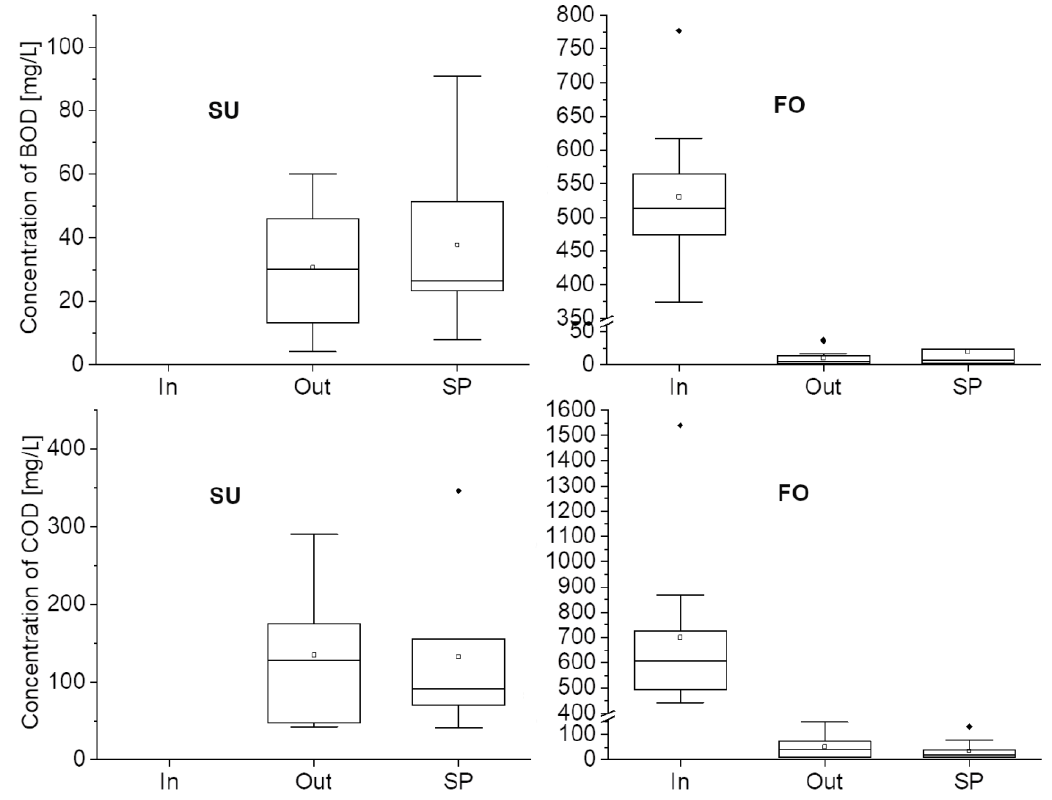
Figure 3. BOD 5 and COD concentration comparison during SU = start-up phase and FO = full-scale operation, In = inlet, Out = outlet, SP = stabilization pond.